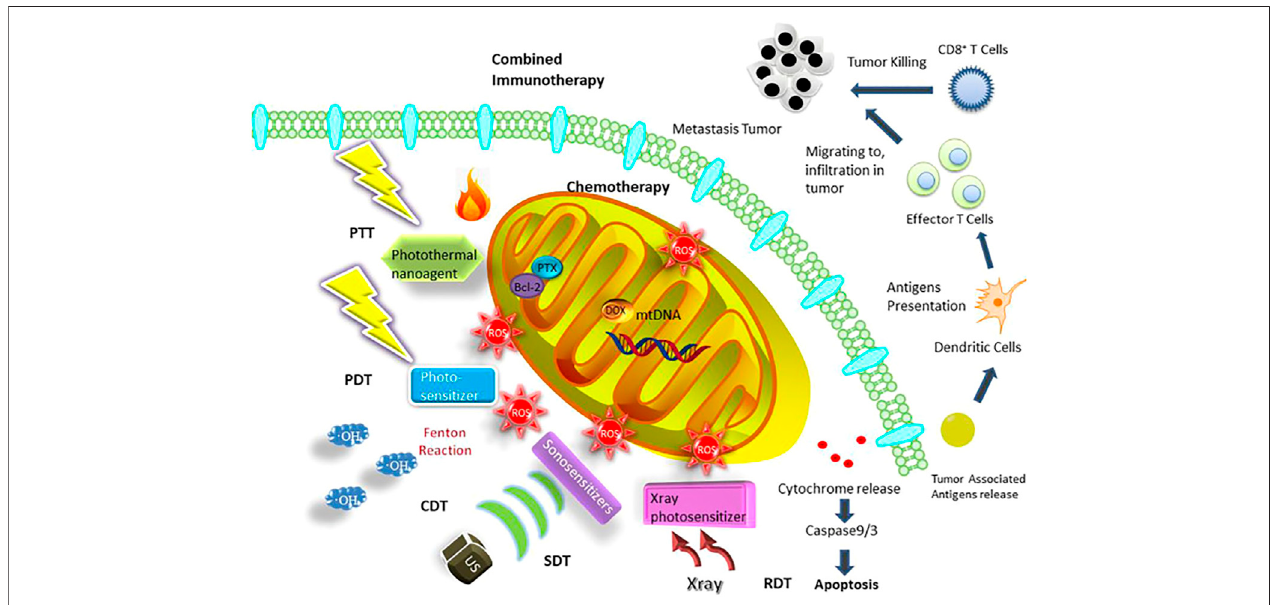
FIGURE 1 | Mitochondria-targeted therapeutic strategies based on nanosystems containing chemotherapy, PDT, PTT, SDT, CDT, RDT, and combined immunotherapy (Gao et al., 2021).